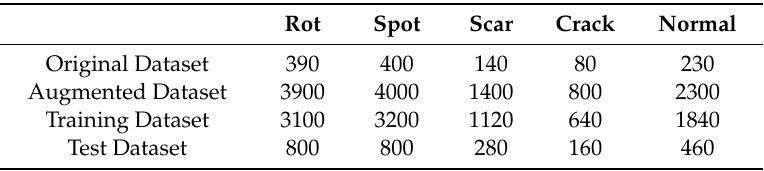
Table 1. Distribution of dataset.